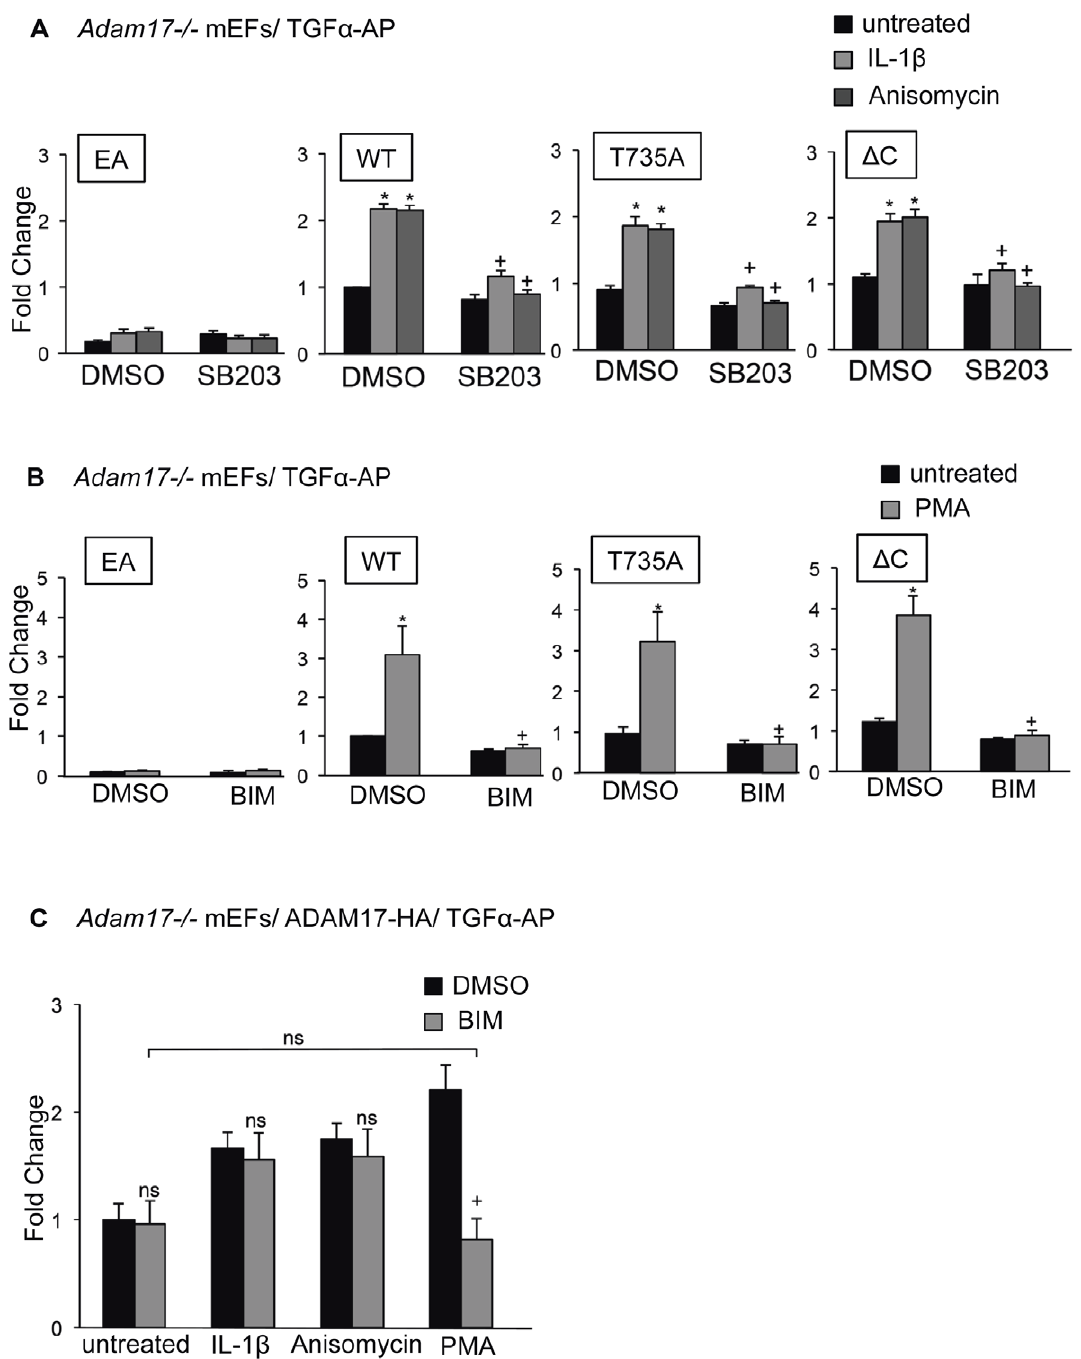
Figure 2. Effect of inhibitors of p38 MAPK or PKC on stimulated shedding by ADAM17T735A and ADAM17 D C. A) Adam17 2 / 2 mEFs were co-transfected with TGF a -AP and murine WT ADAM17, EA, T735A or D C mutants, and either not treated (black bars) or stimulated with IL-1 b (5 ng/ml, light grey bars) or anisomycin (1 m M, dark grey bars), in the presence or absence of 10 m M of the p38 MAPK inhibitor SB203580 (SB203) as indicated, with DMSO serving as a control. Constitutive and stimulated shedding of TGF a -AP was rescued by cotransfection with WT ADAM17 as well as the T735A and D C mutants, but not by the inactive EA mutant. There was no significant difference between the constitutive or stimulated shedding of TGF a -AP from Adam17 2 / 2 mEFs rescued with WT compared to the T735A or D C mutant of ADAM17. IL-1 b and anisomycin-stimulated shedding of TGF a -AP in cells rescued with WT, T735 or D C was blocked to a comparable extent by 10 m M of the p38 MAPK inhibitor SB203580. B) TGF a -AP shedding from Adam17 2 / 2 cells rescued with WT ADAM17, T735A or D C was stimulated to a comparable level by 25 ng/ml PMA (untreated, black bars, PMA-treated, grey bars), and the stimulation could be blocked by the PKC inhibitor BIM I (4 m M). C) Adam17 2 / 2 mEFs transfected with TGF a together with WT ADAM17 were stimulated with 5 ng/ml IL-1 b , 1 m M anisomycin or 25 ng/ml PMA in the presence or absence of 4 m M BIM I. BIM I blocked the TGF a -AP shedding stimulated by PMA, but had no significant effect on the shedding stimulated by IL-1 b or anisomycin. All results represent the average values of at least 3 experiments, and the error bars indicate + / 2 standard error of the mean (sem). Asterisks indicate a significant increase upon addition of a stimulus, whereas plus ( + ) indicates a significant decrease in stimulated shedding upon introduction of an inhibitor (students t-test, p , 0.05).